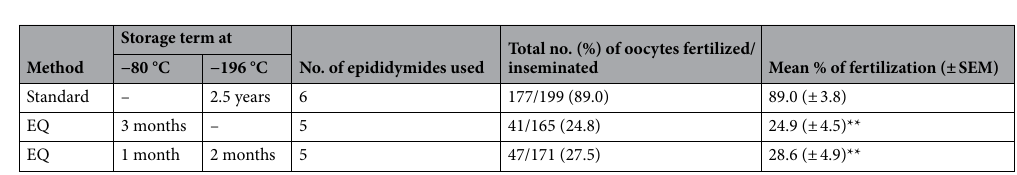
Table 3. Fertilization rates following IVF using B6J sperm frozen by the standard method and stored for 2.5 years and the EQ method and stored for 1–3 months. ** P < 0.01 vs standard cryopreservation method by Mann–Whitney nonparametric U test. SEM, standard error of the